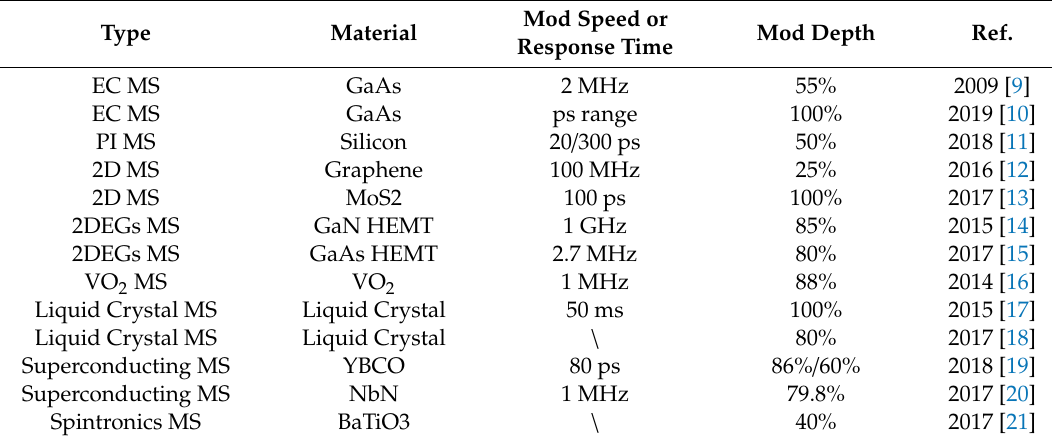
Table 1. THz amplitude modulator type, materials, and basic performance.